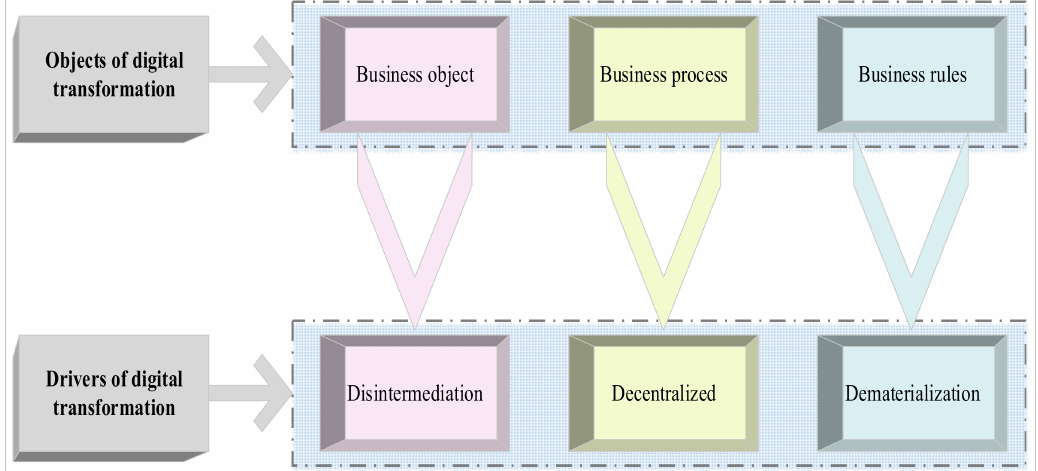
Figure 3. EDT flow of manufacturing